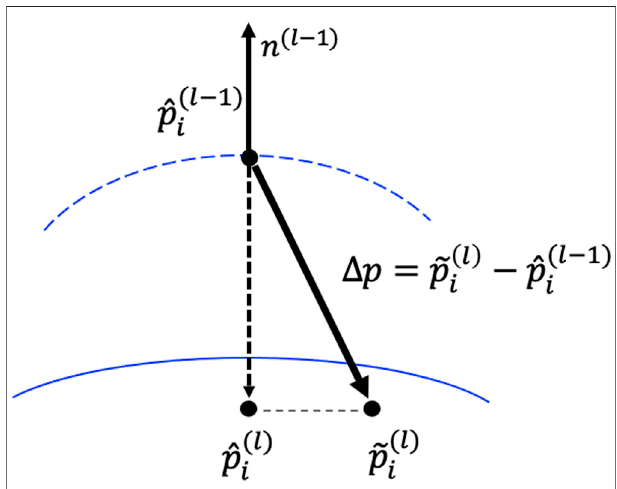
FIGURE 5 | Schematic representation of the VIPDA iteration. We report the original point ^ p ( l − 1 ) i obtained at the ( l − 1) iteration, with the normal to the tangent plane n ( l − 1) with ^ p ( l − 1 ) i . At the iteration ( L ), the position of the point is updated obtaining the point ~ p ( l ) i